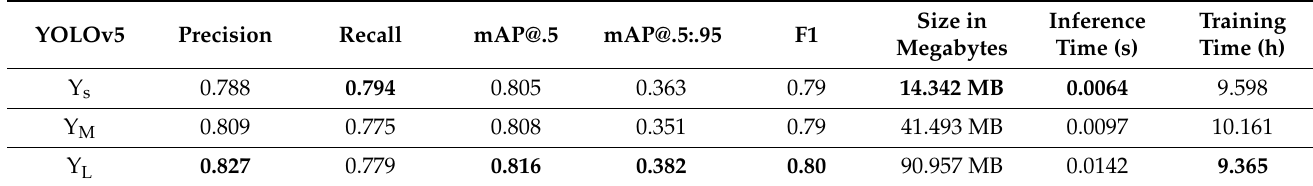
Table 5. Detecting weed growth results using YOLOv5